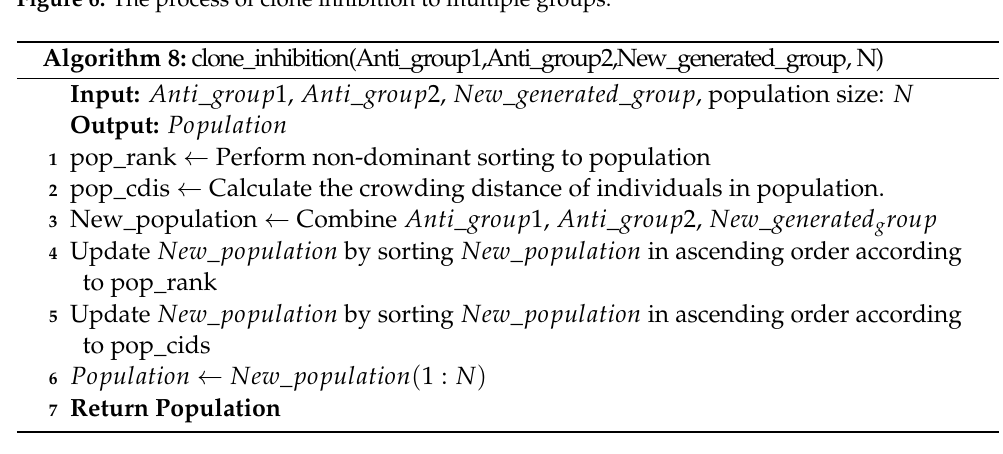
Figure 6. The process of clone inhibition to multiple